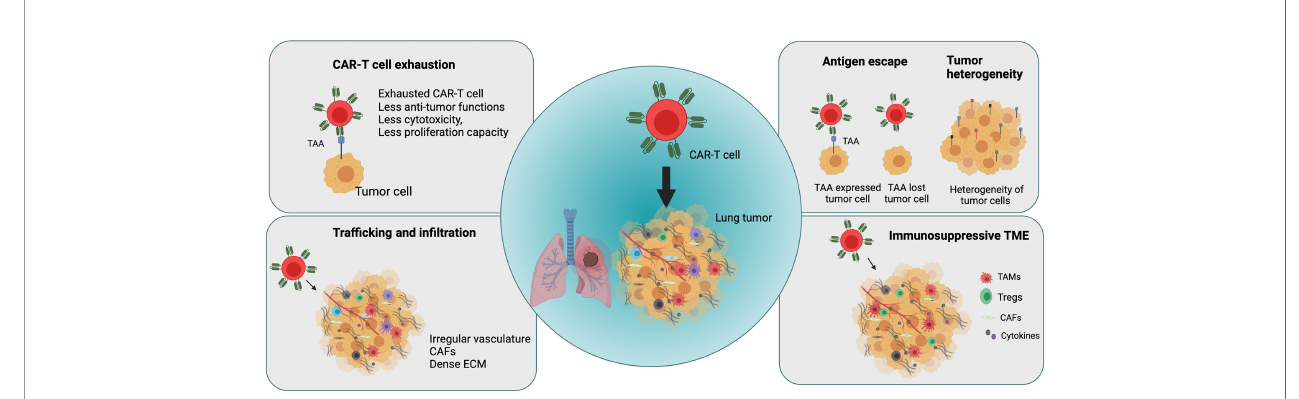
FIGURE 3 | Major challenges in applying CAR-T cell therapy in lung cancer (Figure generated using Bio